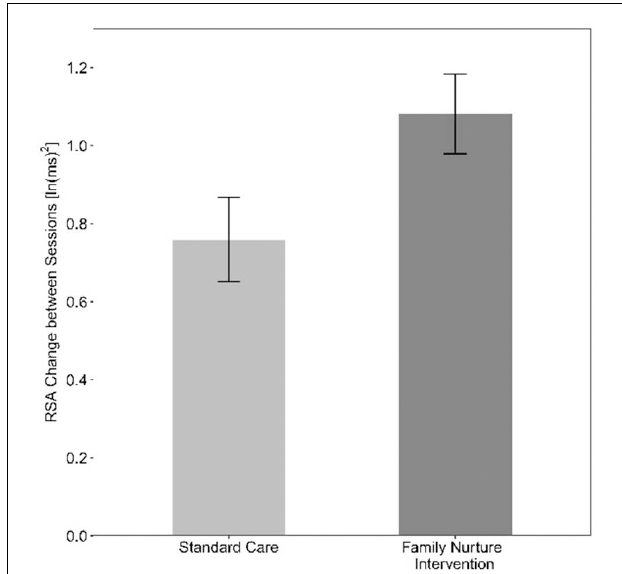
FIGURE 7 | As the infants approached term, increases in RSA were significantly greater in infants receiving FNI compared to the SC group ( p = 0.031; Cohen’s d = 0.38; error bars represent standard